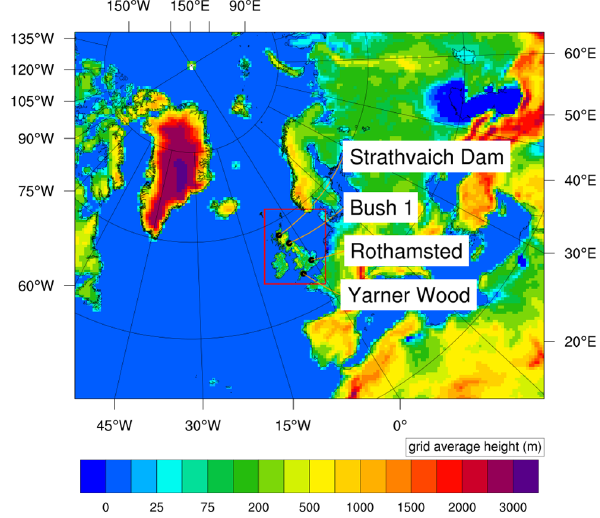
Figure 1. The EMEP4UK Greater European domain, modelled at 50km×50km horizontal resolution and, outlined in red, the nested British Isles domain, modelled at 5km×5km horizontal resolu- tion. The colour scale indicates grid-average altitude. The four UK AGANet measurement sites used in this study are also